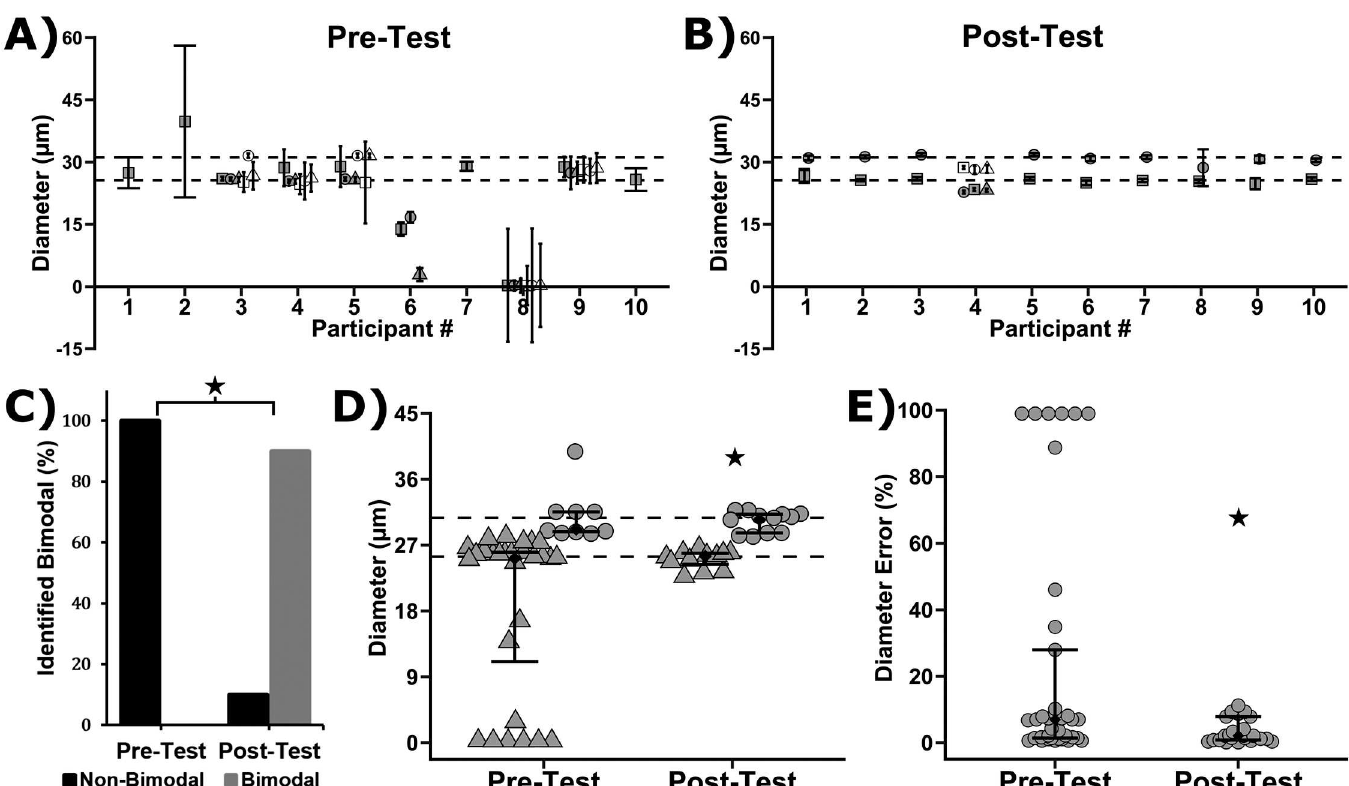
Fig 3. Fiber diameter measurements from 10 participants before and after training. (A,B) Reportedfiber diameter and reportedstandarddeviationfrom each participant in the Pre-Test (A) and Post-Test (B). Note that the test images containeda mix of steel wires with two diameters (48 gauge = 31.1 μ m dia.; 50 gauge = 25.6 μ m dia.). The dotted lines indicate the knownwire diameters. (C) Plot showingprevalence of identifying two diameters of wire (Bimodal)in the steel sample as a function of the Pre-Test and Post-Test. Plot of the number of participants that correctly determinedthat the test images containeda mix of two wire diameters (bimodal).There was a significantdifference betweenthe Pre-Test and Post-Test (Fisher’s Exact Test, P < 0.001). (D) Gray symbols are the individual participant responses and black diamonds are median with first and third quartiles(9 (cid:20) n (cid:20) 28). Participantresponses that were < 28.35 μ m or > 28.35 μ m were binnedwith the 50 gauge (25.6 μ m dia., Triangles)or 48 gauge (31.1 μ m, Circles) wire, respectively. Note that 28.35 μ m is the midpoint between25.6 μ m and 31.1 μ m. The star indicatesa significantdifference betweenthe Pre-Test and Post-Test (variances for 25.6 μ m and 3.1. μ m were pooled;Levene’s Test, 9 (cid:20) n (cid:20) 28, P < 0.05). (E) Gray symbols are the errors of the individual participantresponses and black diamonds are the error median with first and third quartiles(9 (cid:20) n (cid:20) 28). The star indicatesa significantdifference (2-way analysisof variance,P <